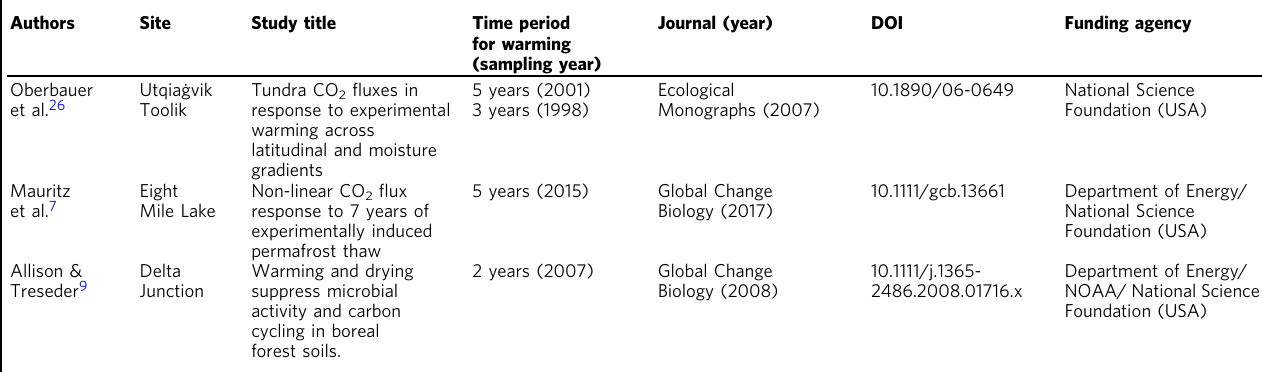
Table 1 Data sets used in model